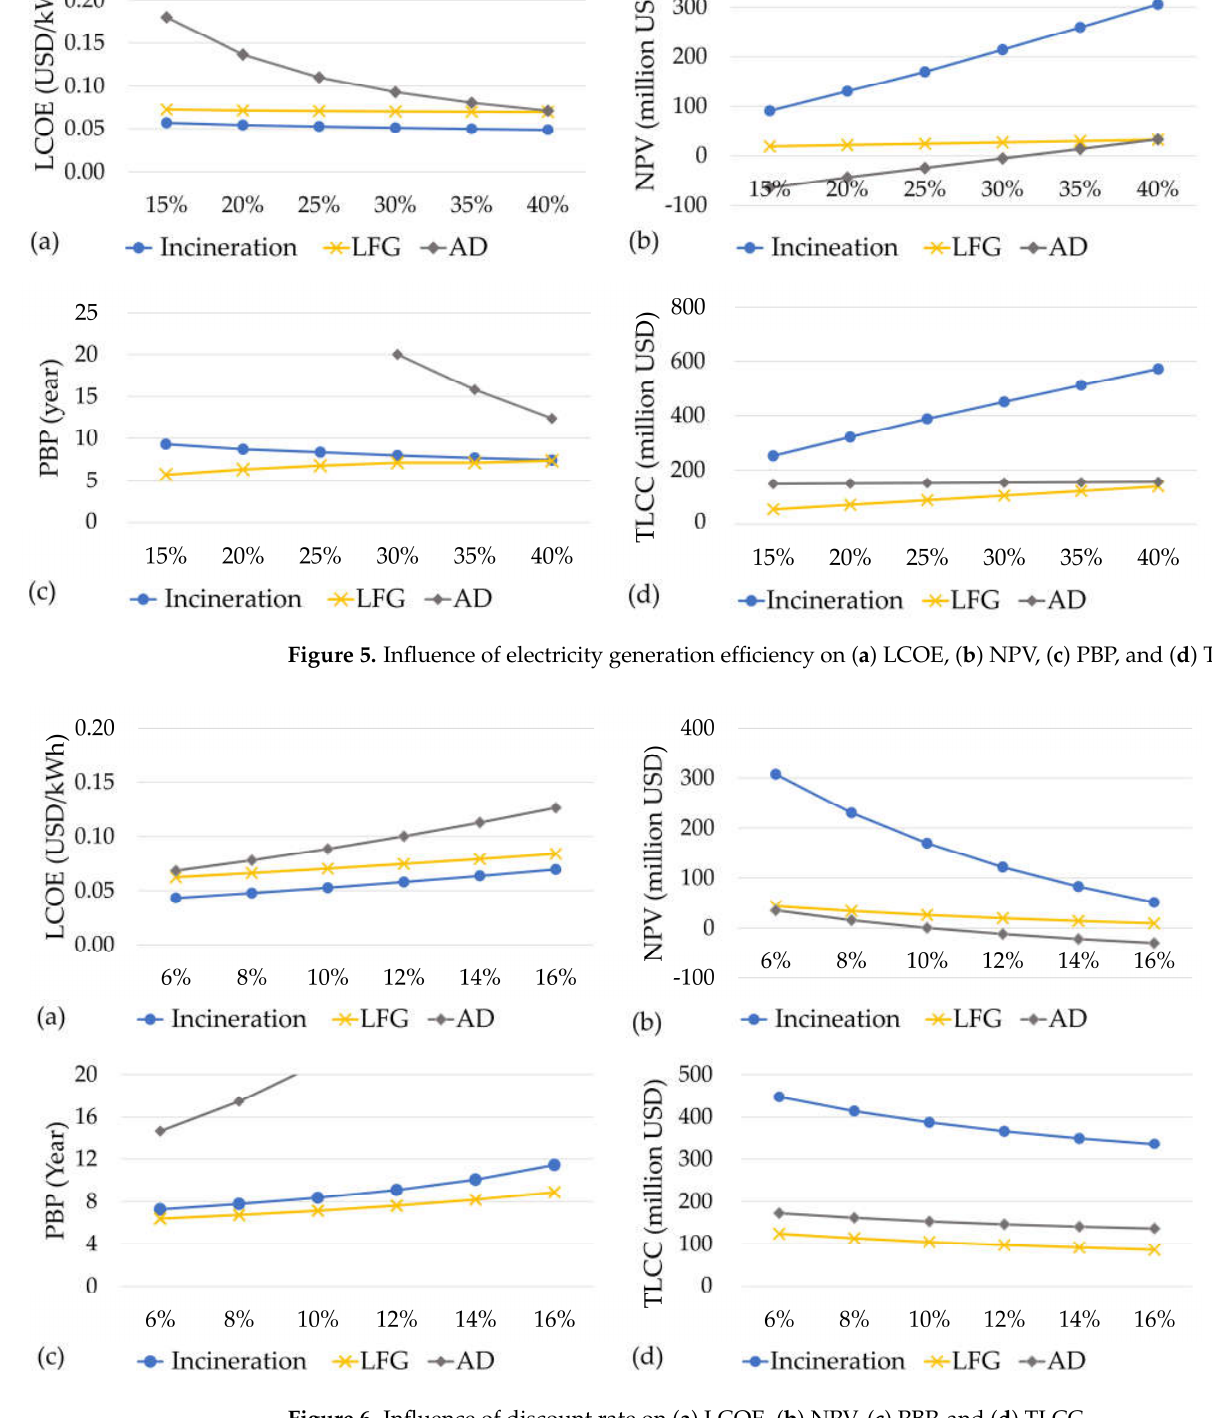
Table 9. Influence of feed-in tariff on NPV, PBP, and IRR